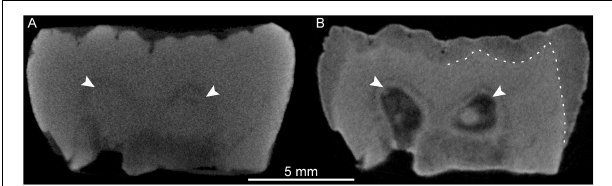
FIGURE 7 | X- µ CT- (A) and n- µ CT-based (B) mesiodistal virtual sections through the buccal cusps of the lower molar SMF-8888. The white arrows indicate the positions of two pulp horns barely discernible on the X-ray image (A) but clearly rendered by the neutron-based record (B) . The dotted line in (B) highlights the enamel-dentine boundary, not visible in (A) .